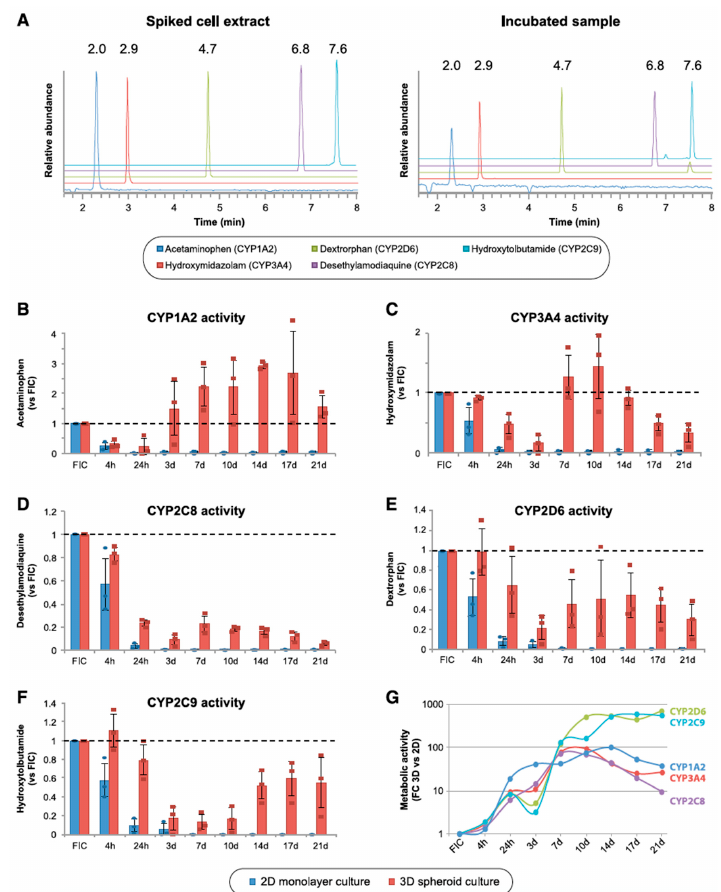
Figure 1. PHHs in 3D spheroid culture show significantly higher functional activities of major human cytochrome P450 (CYP) enzymes compared with PHHs in 2D culture. ( A ) Chromatograms of primary metabolites (acetaminophen, hydroxymidazolam, desethylamodiaquine, dextrorphan, and hydroxytolbutamide) of five CYP probe substrates in a spiked cell extract (each 8 ng / mL) and in a sample incubated for 4 h. Numbers above the peaks are retention times. ( B – F ) The time courses of the metabolic activities of CYP1A2 ( B ), CYP3A4 ( C ), CYP2C8 ( D ), CYP2D6 ( E ), and CYP2C9 ( F ) in PHHs from three donors cultured in 2D monolayer or 3D spheroid cultures. Dashed lines: metabolite levels in freshly isolated cells (FICs), taken as unity. Error bars = SD. ( G ) Line plot of changes of CYP activity ratios in 3D vs. 2D culture in panels ( B – F ) (FC: fold change). CYP metabolic activities are much greater in the spheroids during prolonged incubation. Reprinted from reference